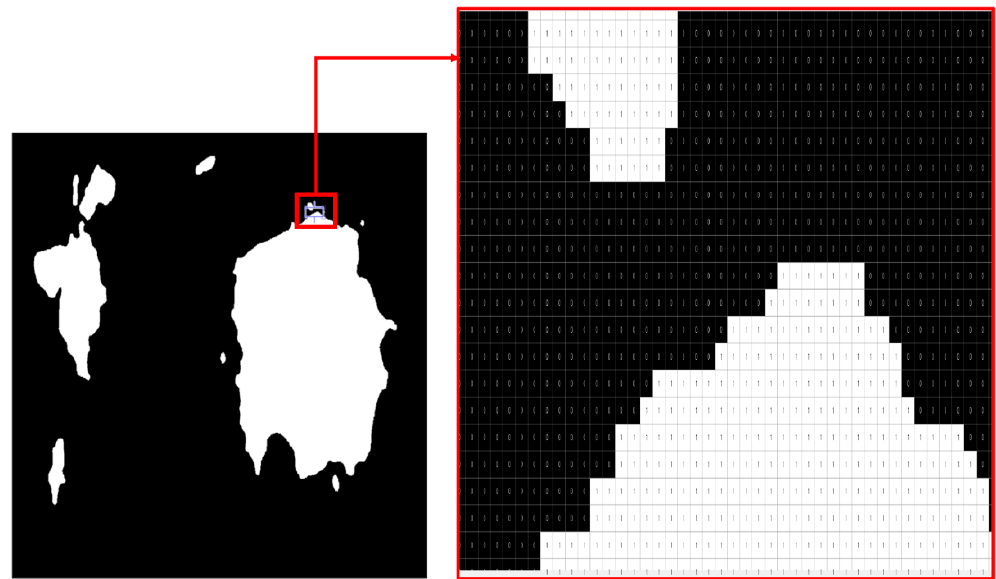
Figure 8. The creation of a binary image using the threshold image segmentation technique.